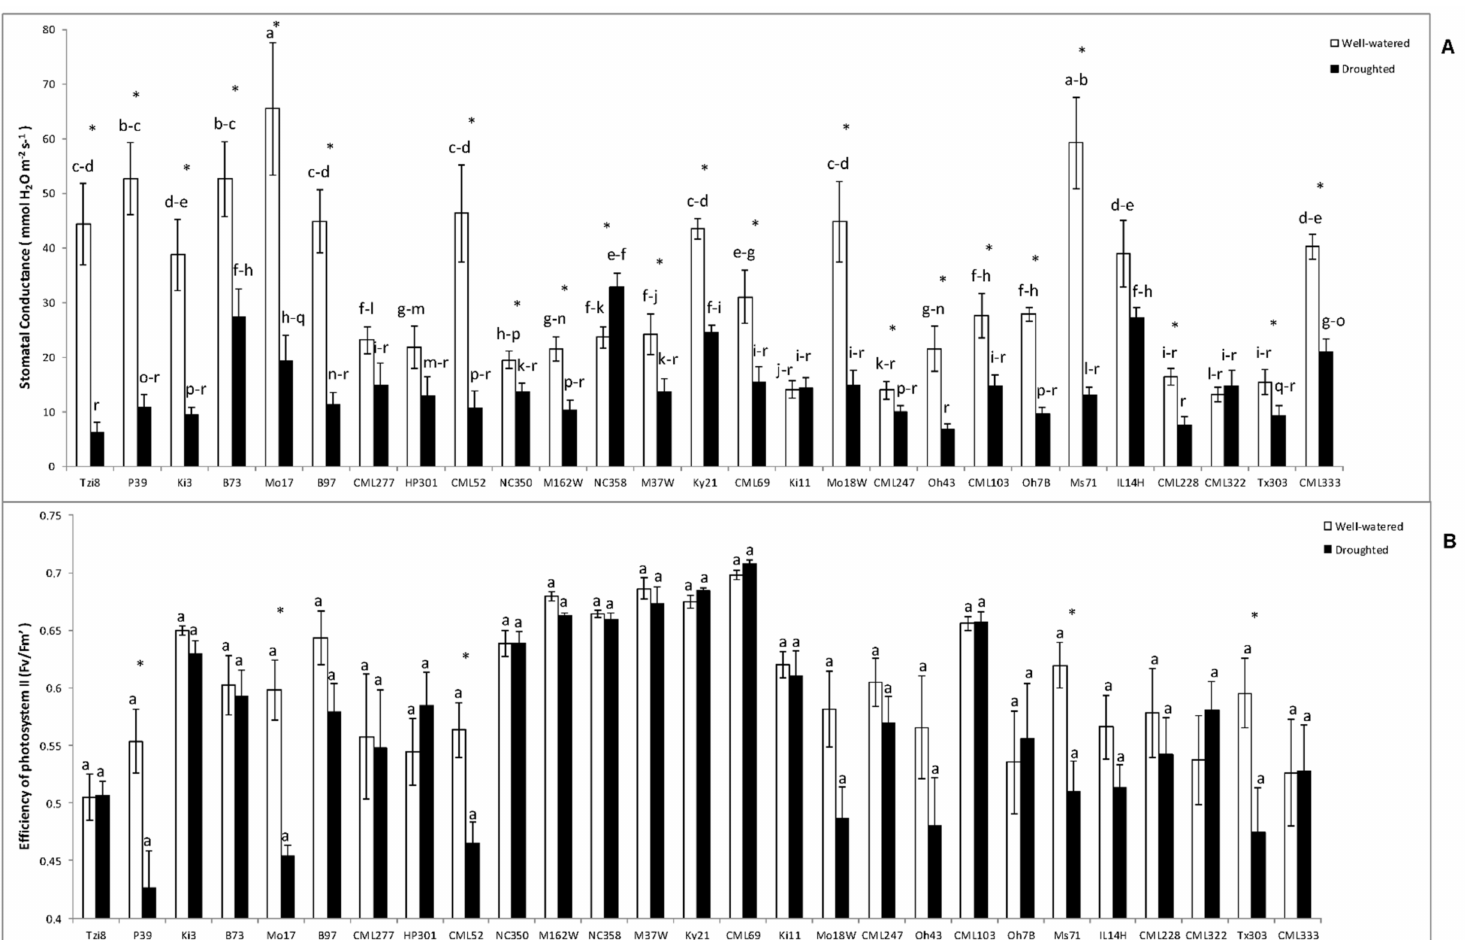
Figure 2. ( A ) Stomatal conductance (gs) and ( B ) photosystem II efficiency in the light-adapted state ( ∆ Fv/Fm’) in the whole maize NAM population cultivated under well-watered conditions or subjected to drought stress. Data represents the means of 10 values ± S.E. Different letters indicate significant differences between treatments ( p < 0.05) based on Duncan’s test. Asterisks indicate significant differences between well-watered and droughted treatments within each maize line, according to Student’s t